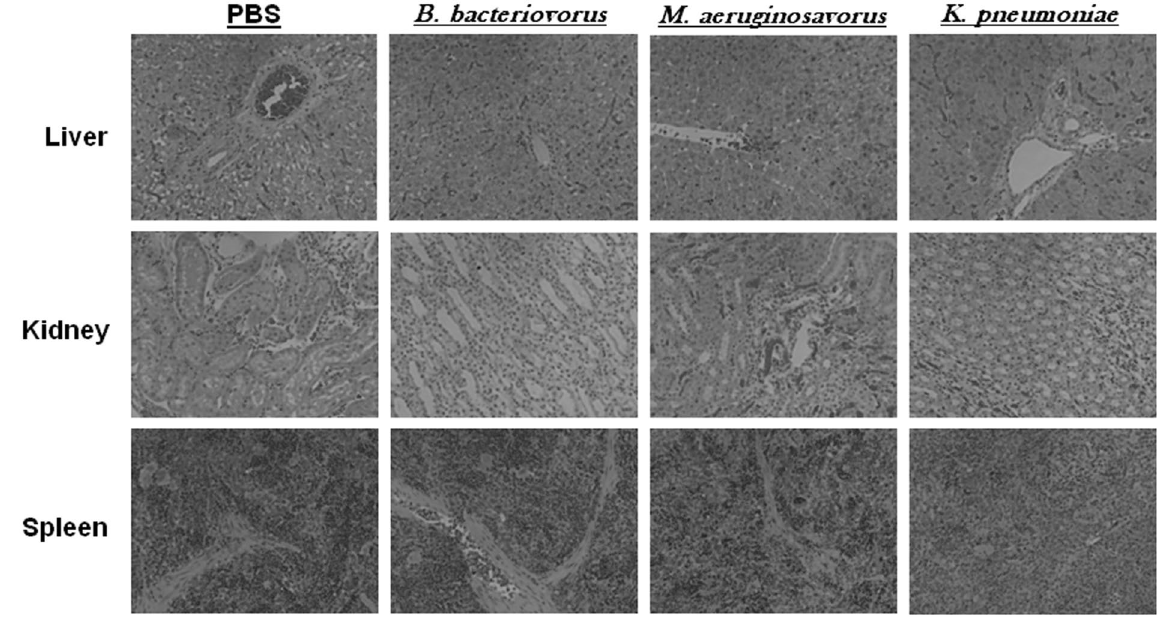
Figure 1. Histological examination of rat organs after intravenous inoculation of predatory bacteria. SD rats were intravenously inoculated (through tail vein injection) with PBS, B. bacteriovorus , M. aeruginosavorus , or K. pneumoniae . Histological examination of harvested rat livers, kidneys, and spleens exposed to B. bacteriovorus and M. aeruginosavorus revealed no abnormal pathology compared to rats treated with PBS. All images are representative micrographs that were taken at 18 hours post-inoculation and at X40 total